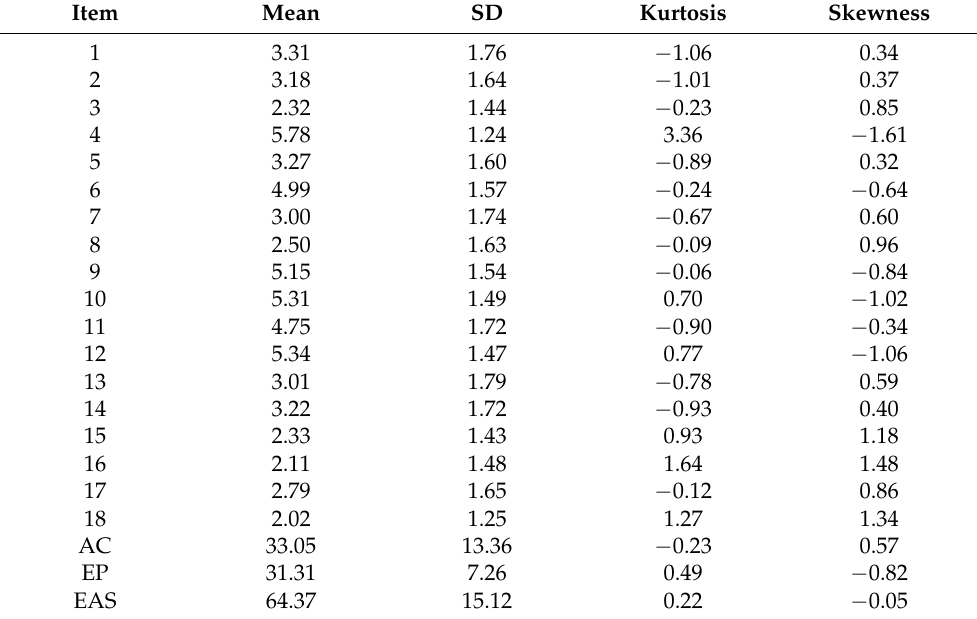
Table 3. Descriptive statistics for each EAS item, EAS subscale, and total scale